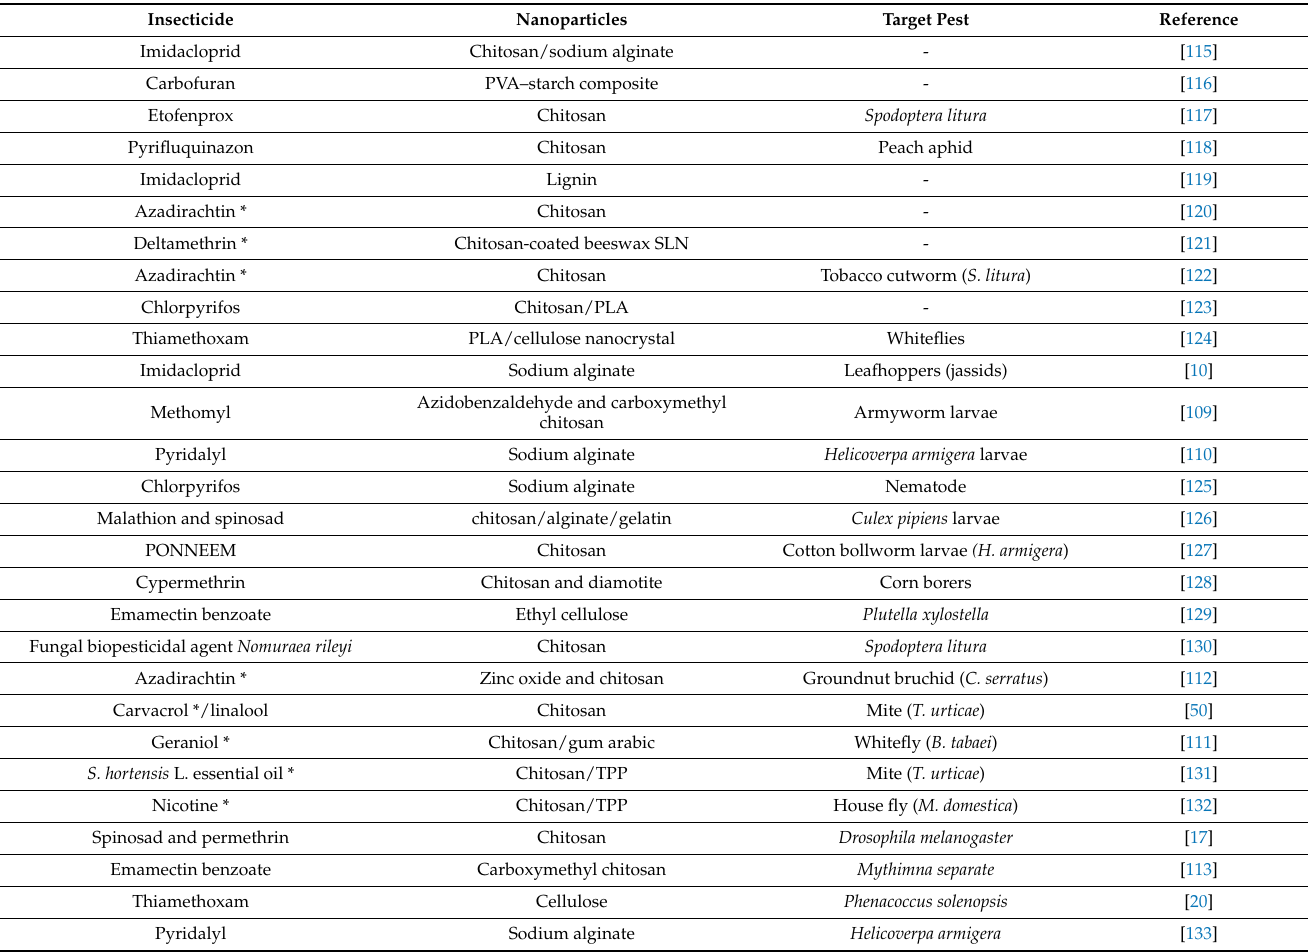
Table 3. Biopolymeric nanoparticles tested as carriers of